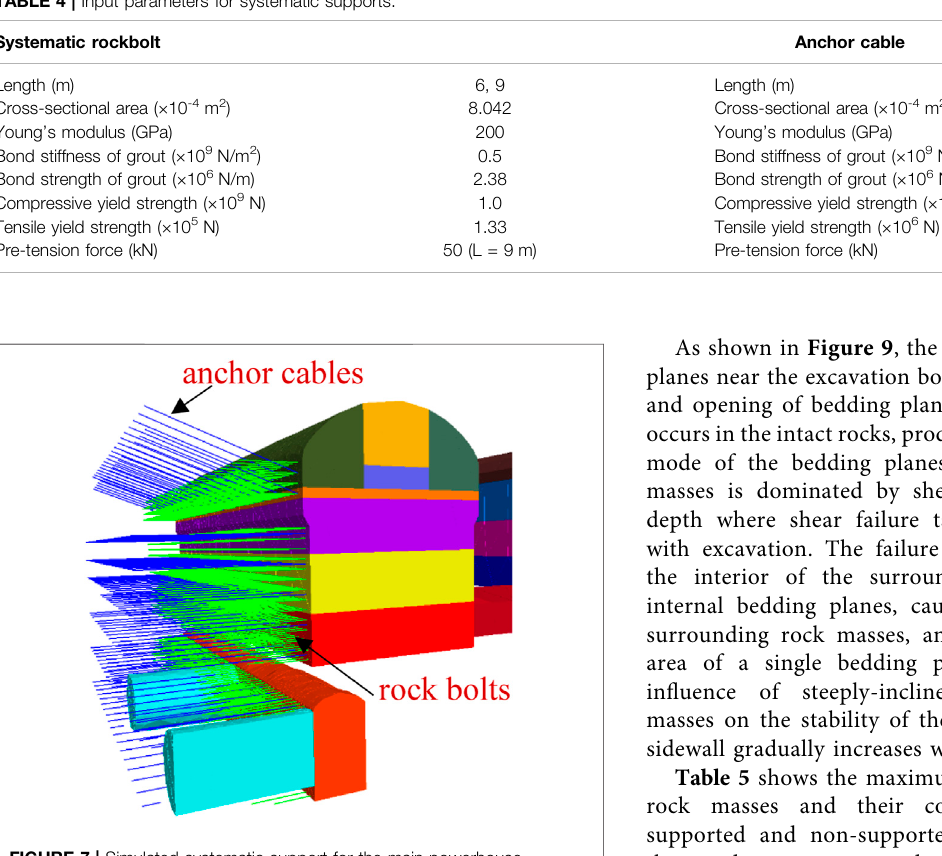
FIGURE 7 | Simulated systematic support for the main